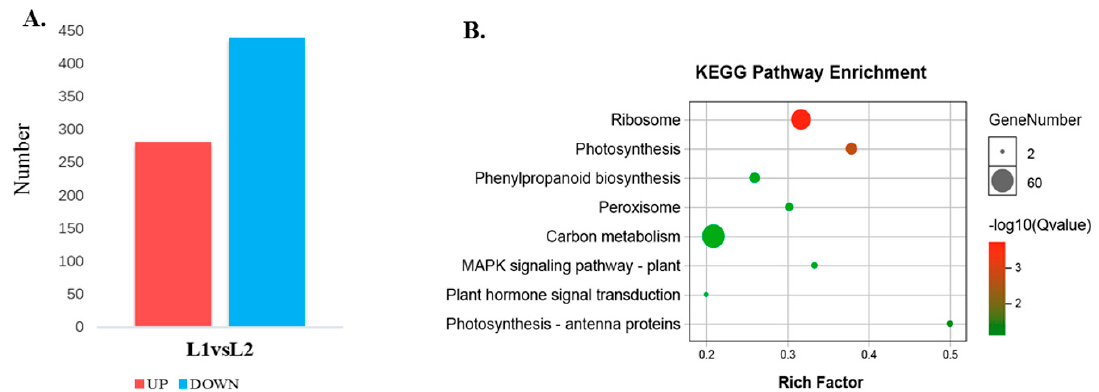
Figure 6. Different expression proteins in L1 and L2 and the KEGG pathway enrichment. ( A ) The statistics of different expression proteins in L1 and L2; ( B ) the KEGG pathway enrichment analysis of the different expression proteins.